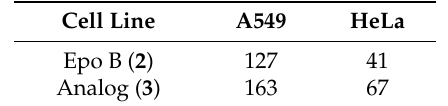
Table 1. Human cancer cell growth inhibition (IC 50 ; nmol/L).